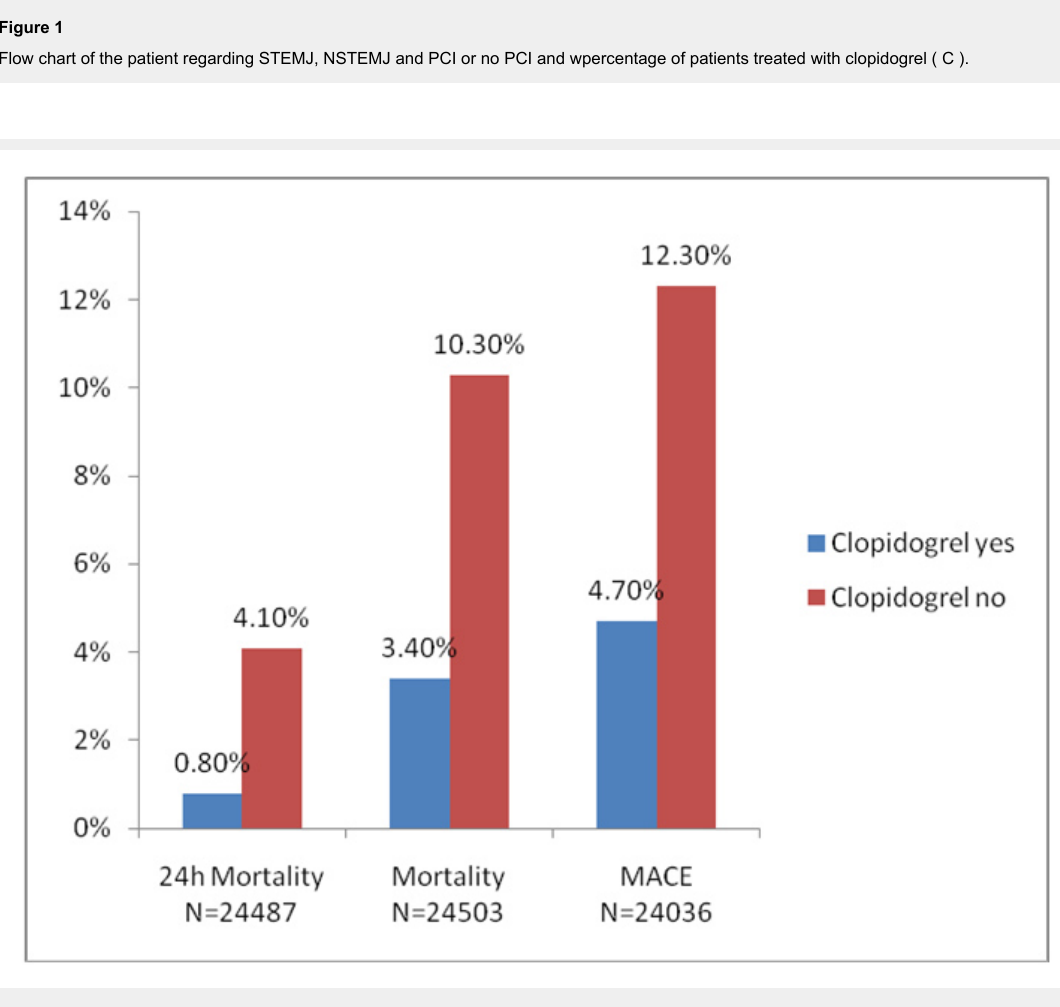
Figure 2 Effect of early clopidogrel administration (within 24h of admission) on 24h mortality, in-hospital mortality, and MACE. The effect of clopidogrel is statistically significant with p < 0.0001 in Fisher's exact test in all